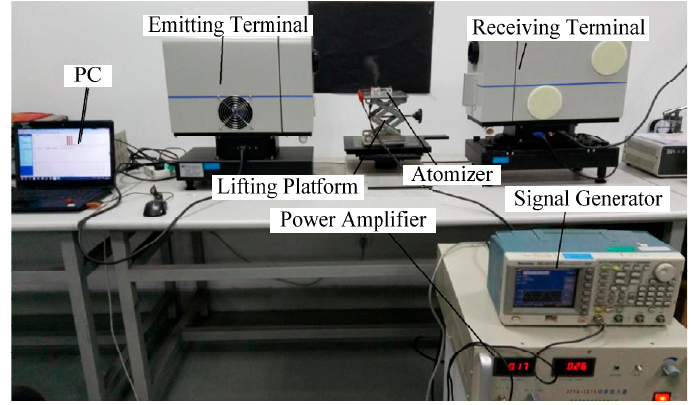
Figure 8. Measurement of the particle size of the atomized particles.